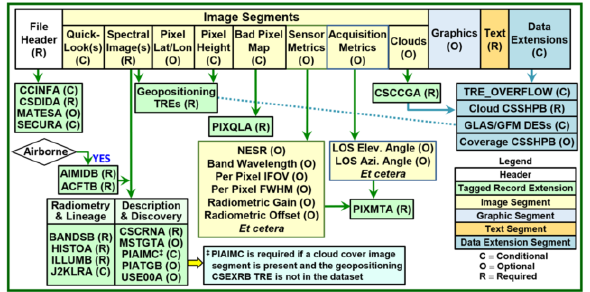
Figure 6 . SNIP version 1.0 dataset